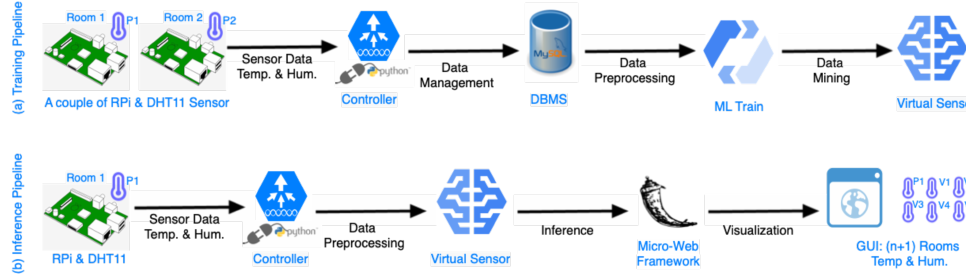
Figure 2. Logical flow of training and inference IoT virtual